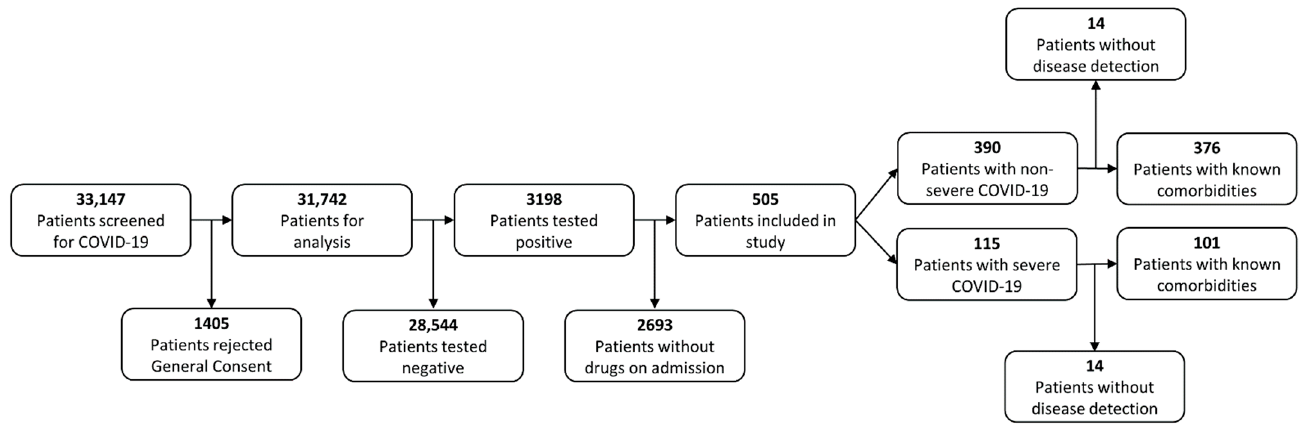
Figure 1. Flowchart of patient selection process.